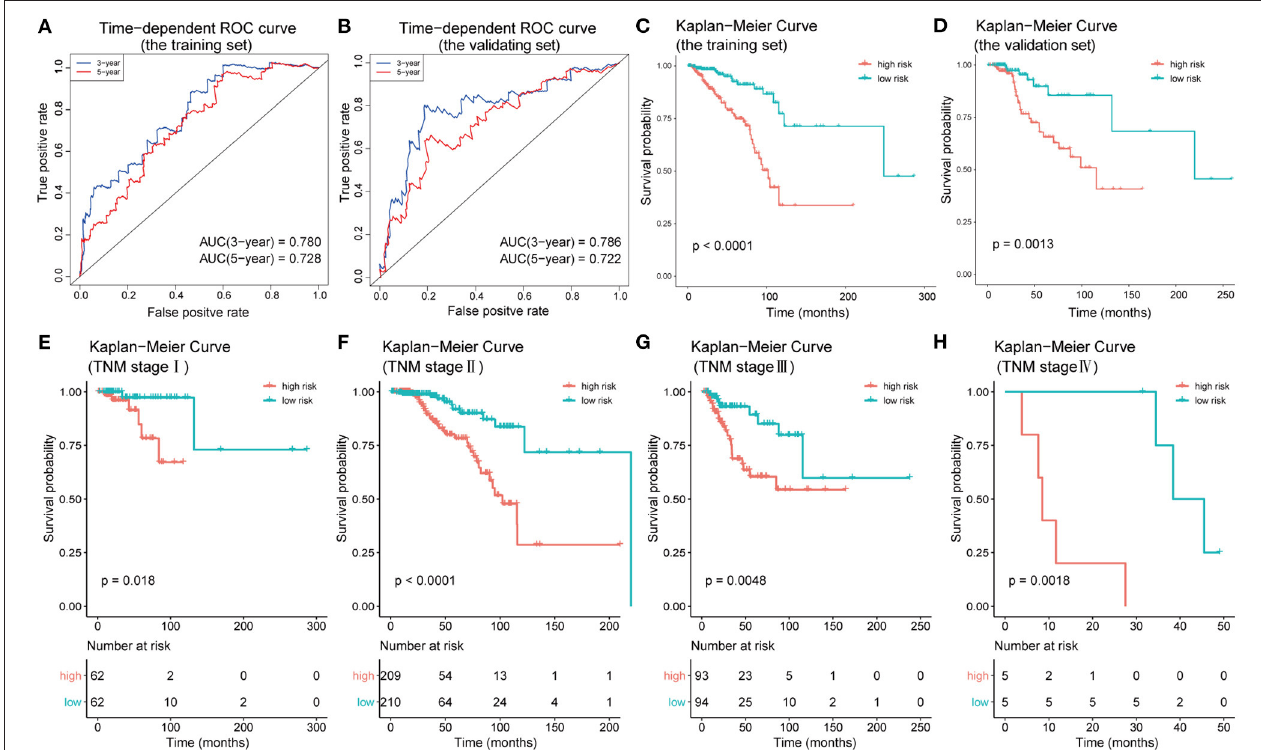
FIGURE 7 | Construction and validation of the prognostic model constructed using IC-SHMSs. Time-dependent ROC analyses for 3- and 5-year OS, respectively, were performed to estimate the prediction accuracy of the prognostic model, using a training set (A) and a validation set (B) . Overall survival curves of the low- and high-risk groups in the training set (C) and the validation set (D) . Overall survival curves of the low- and high-risk groups based on the BC patients in TNM stage I, II, III, and IV (E–H)